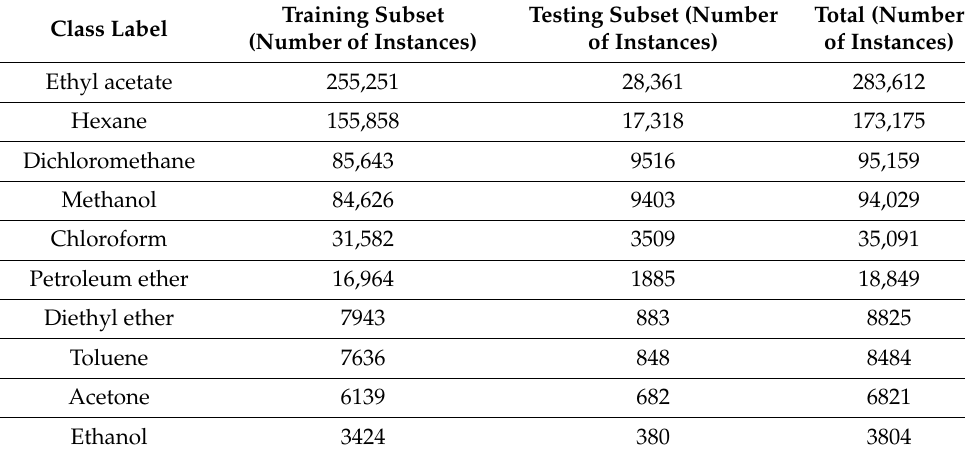
Table 3. Distribution of instances over different class labels (DS1). Class